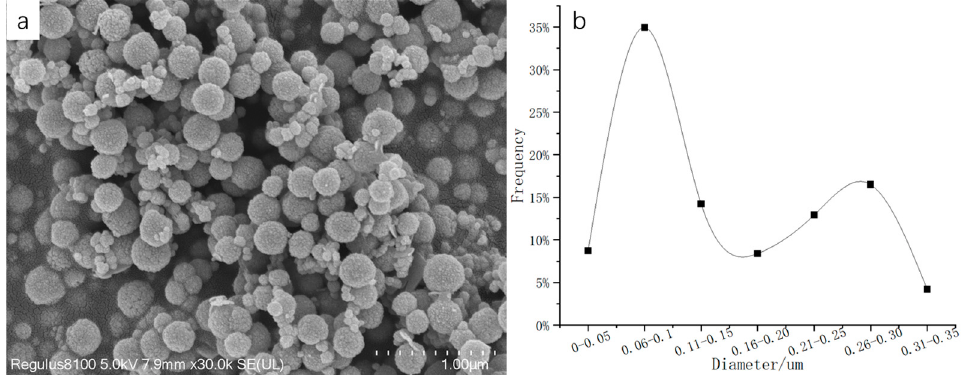
Figure 12. ( a ) SEM image of 3 h preparation of Fe 3 O 4 by microwave method; ( b ) Particle size distribution curves of 300 microspheres in ( a ).